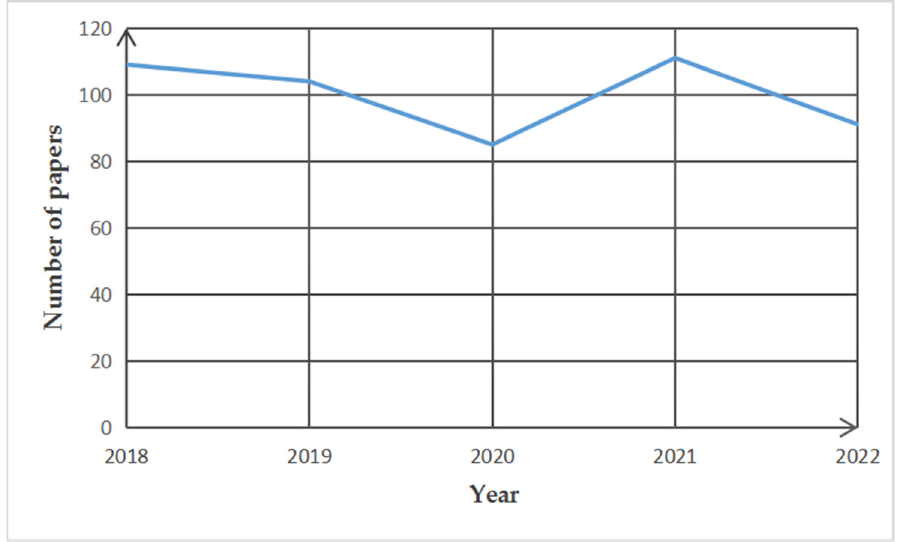
Figure 1. Number of papers published in the fi eld of forest ecosystem services from 2018 to 2022.